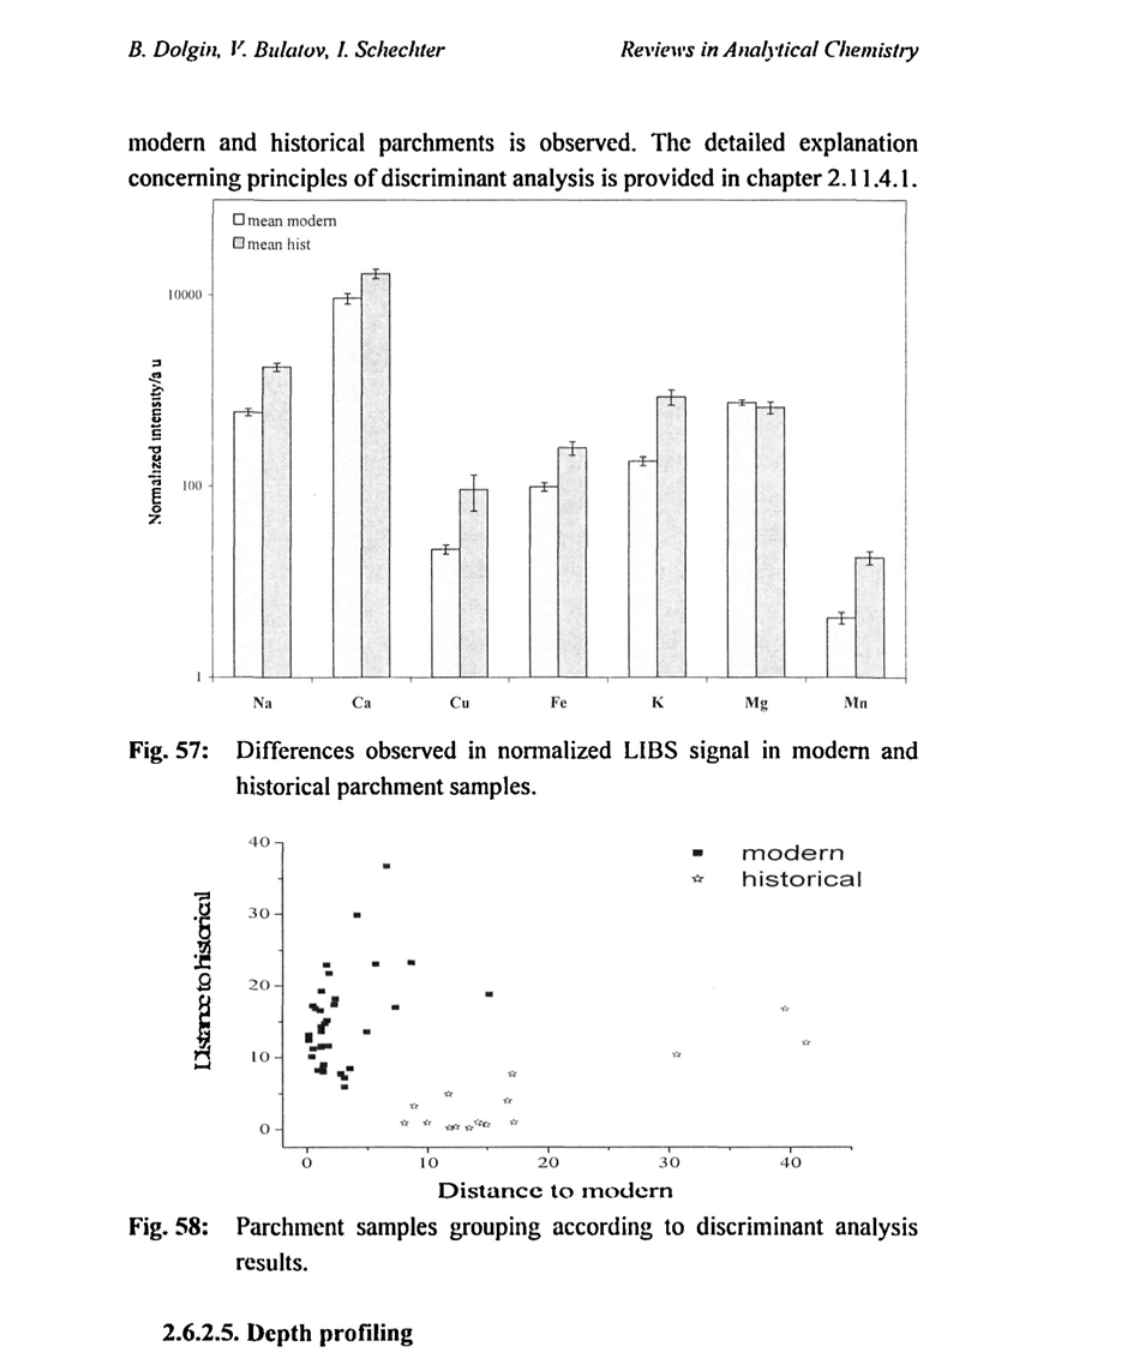
Fig. 58: Parchment samples grouping according to discriminant analysis